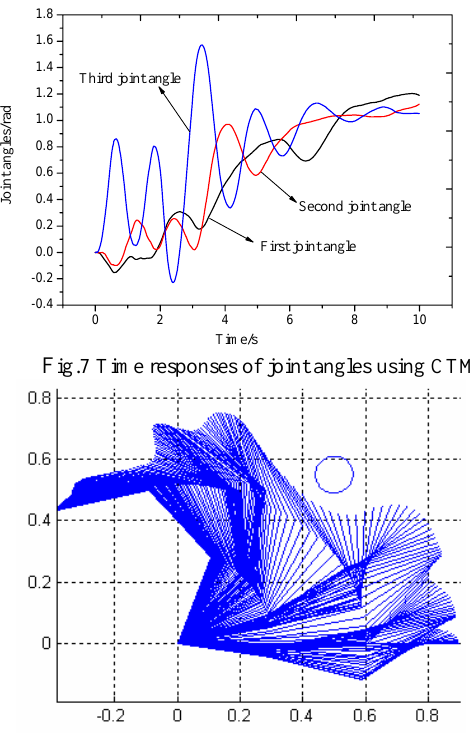
Fig.8 Rest-to-rest planning using CTM: with obstacles in